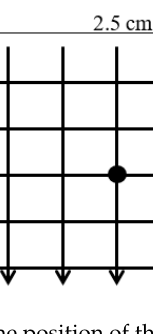
Figure 20. Changing the position of the PSD sensor to confirm illumination.